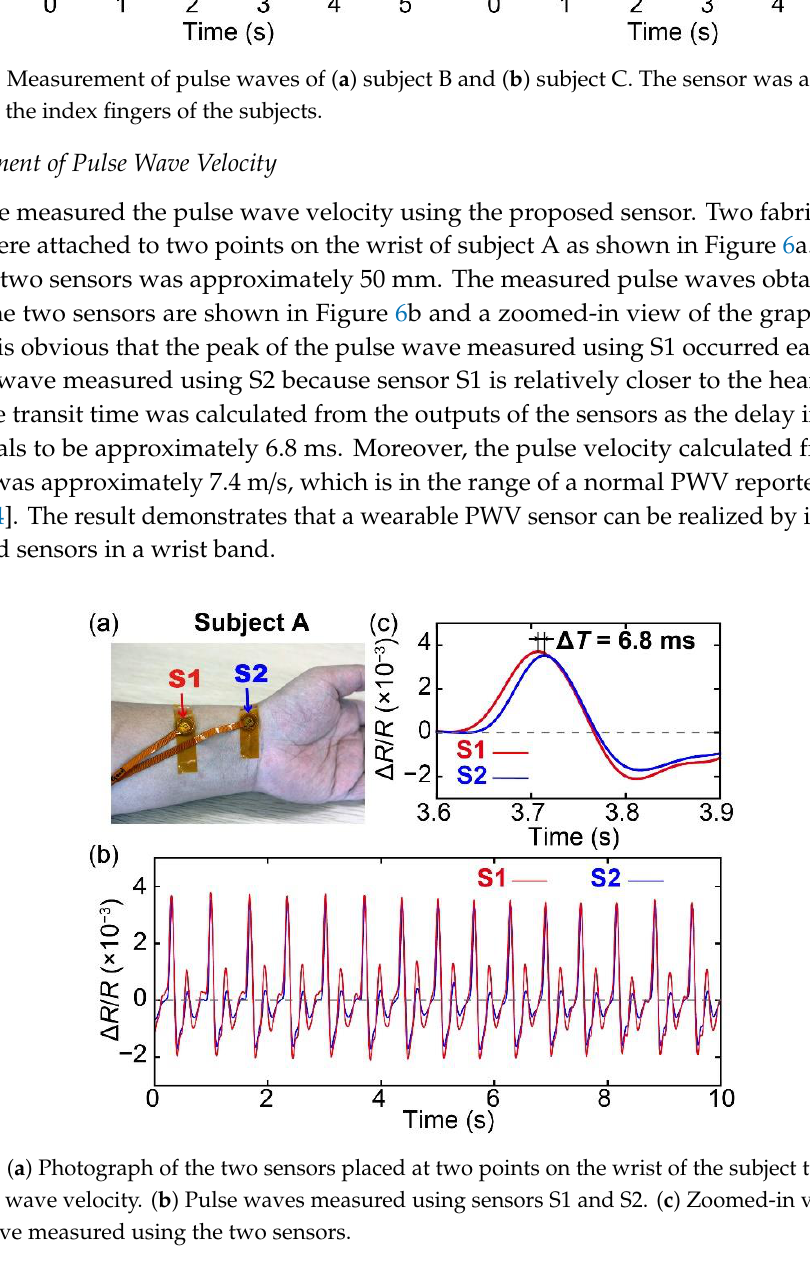
Figure 5. Measurement of pulse waves of ( a ) subject B and ( b ) subject C. The sensor was attached to the tip of the index fingers of the subjects.